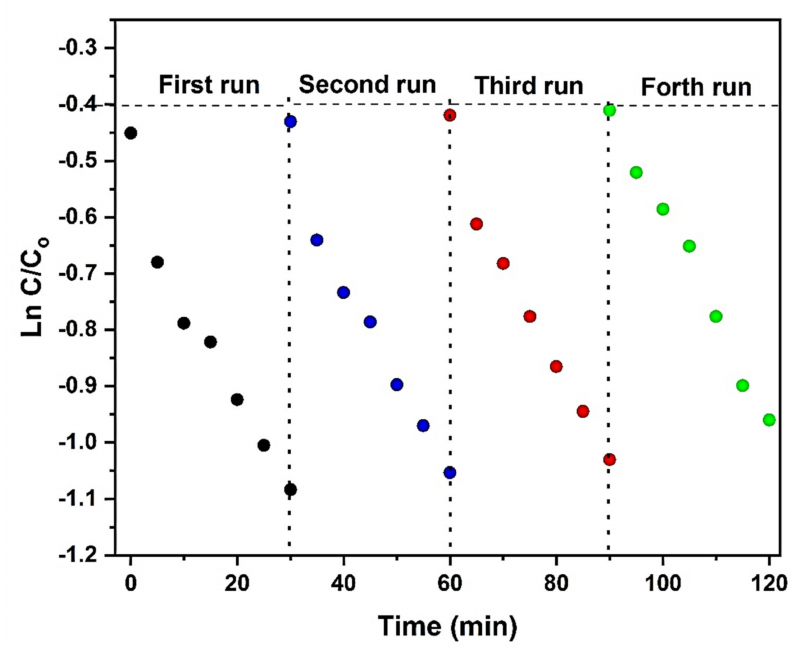
Figure 13. Recycle stability of the photocatalytic decomposition of MB under UV